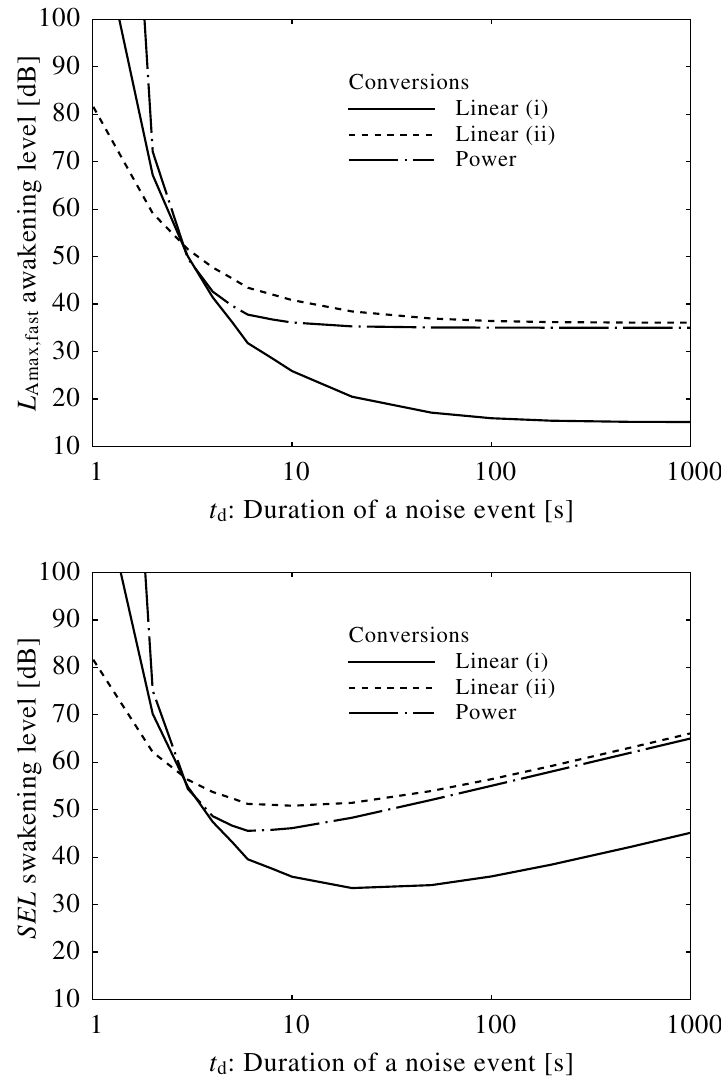
Figure 8. Average awakening levels using L Amax,fast and sound exposure level ( SEL ), where A “ 1.3(mV) and D v “ 3.0(mV). Equations (12) through (14) were used to convert neuroelectrical thresholds into sound